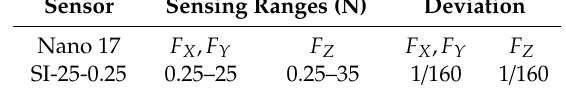
Table 1. Parts and mass of the experimental aircraft model. Table 2. The measurement ranges and deviation of the force sensor used in the experiment.